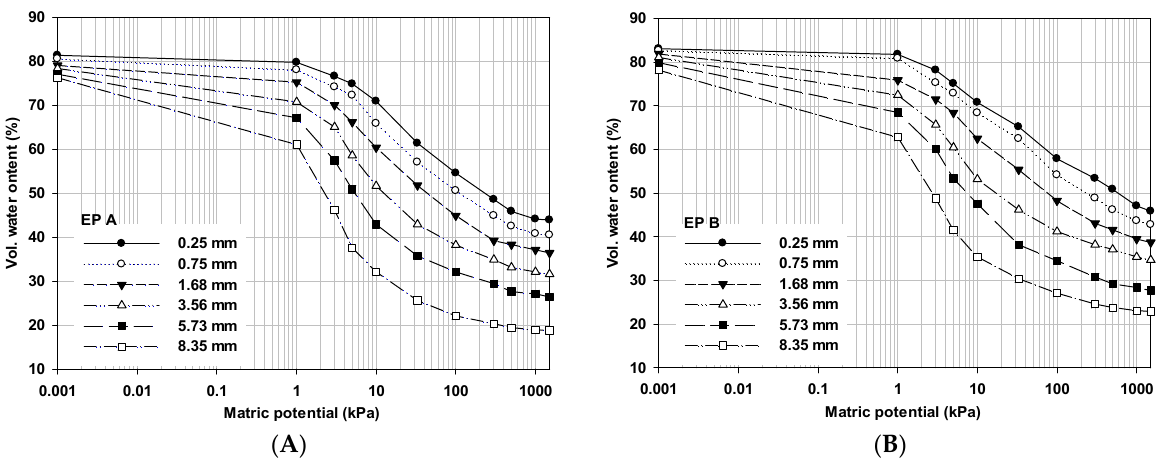
Figure 5. Water retention curves corresponding to the water potential ranging from 0 to − 1500 kPa for six different median particle size ranges for EP A and B, respectively. A: Turkey; B: